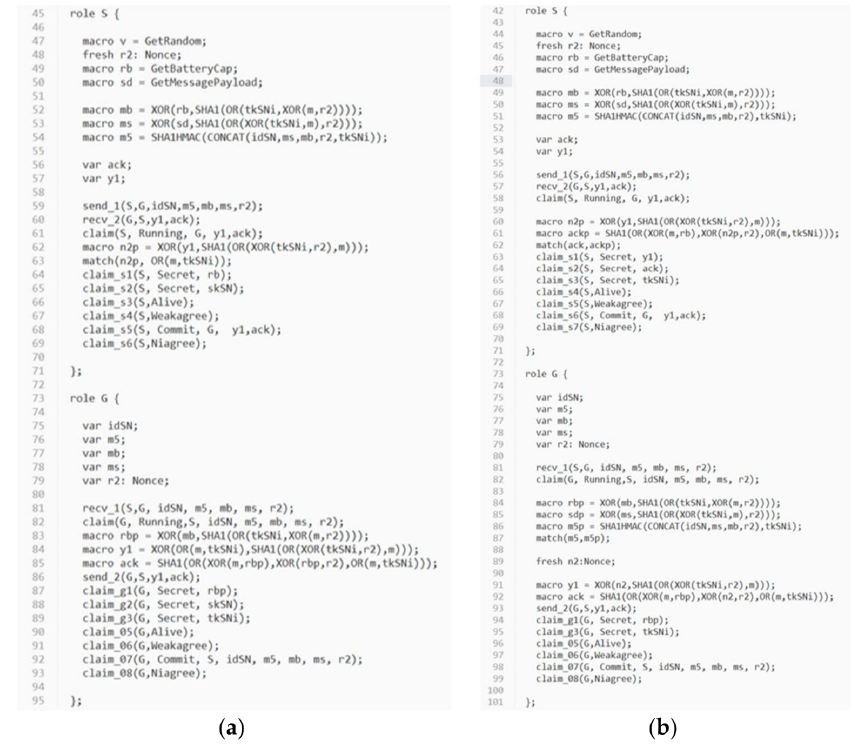
Figure 8. ( a ) The spdl script for the continuous authentication phase in Condition (1); ( b ) The spdl script for the continuous authentication phase in Condition